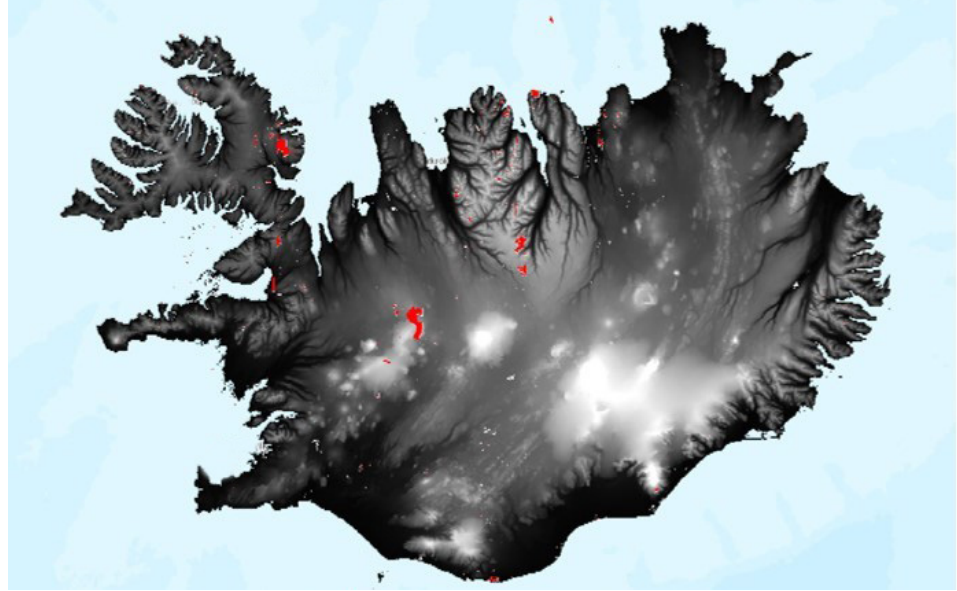
Figure 11. Iceland with red background used to highlight voids.